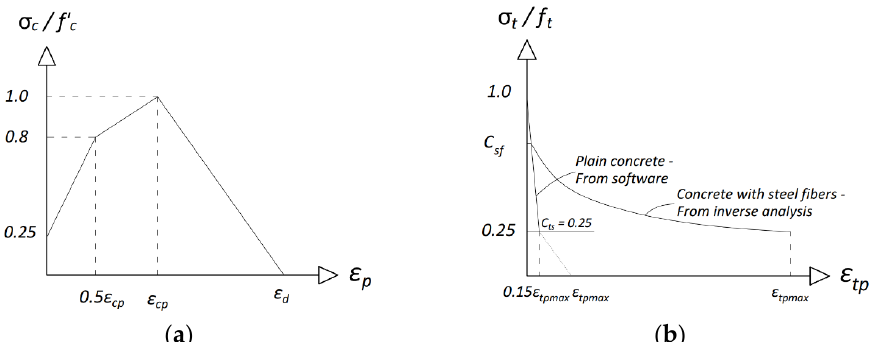
Figure 1. Details of the user concrete material model: ( a ) compressive hardening–softening behav- ior; ( b ) tensile softening behavior. ( b ) tensile softening